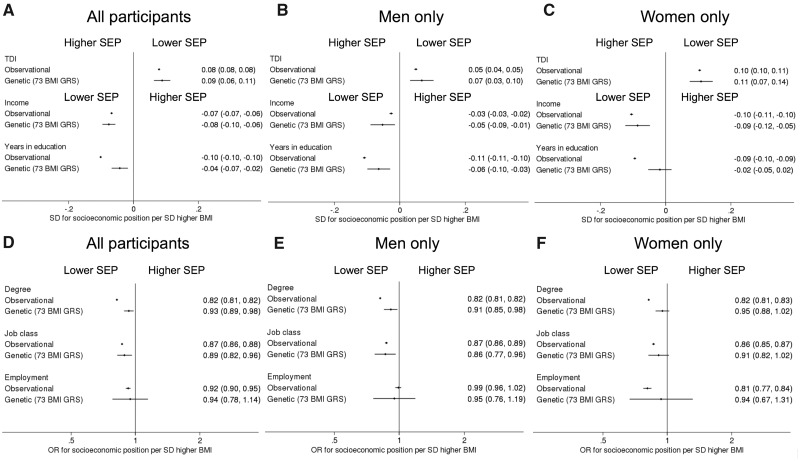
Forest plots of the linear and logistic regression and MR associations between a 1 SD higher body mass index (BMI) and six measures of socio-economic position (SEP). (A–C) represent the differences in continuous SEP measures (TDI, income and years in education) in (A) all individuals, (B) men only and (C) women only. (D–F) represent differences in binary SEP measures (degree, skilled job and employment status) in (D) all individuals, (E) men only and (F) women only. Higher and lower SEP are marked on the plots as higher SEP and lower SEP. Note TDI is the opposite way round to the other SEP measures, with higher values representing more deprivation.